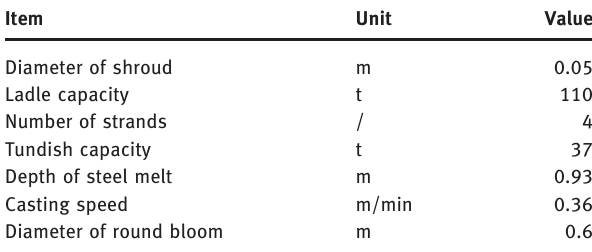
Figure 2: The tundish with